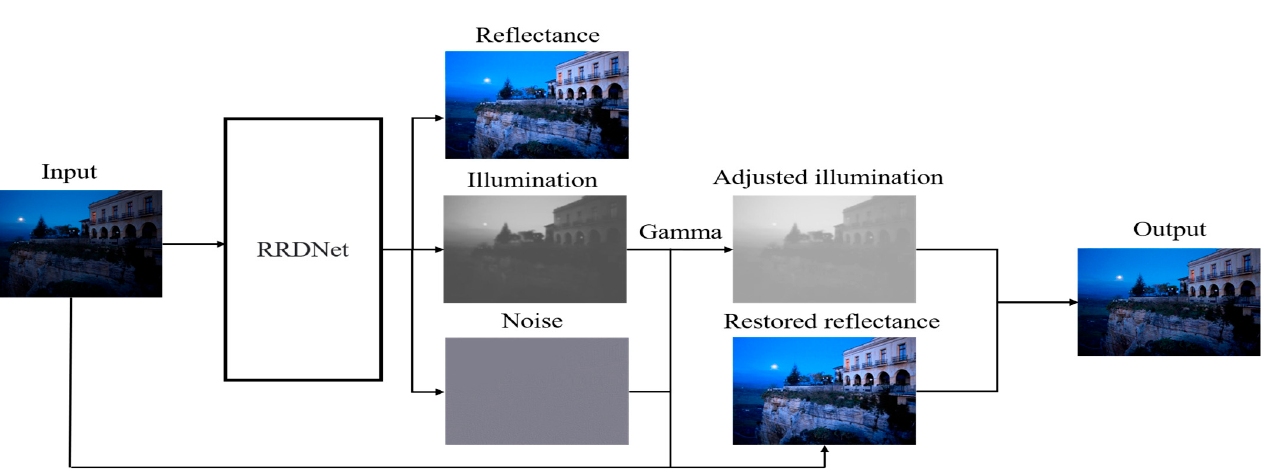
Figure 5. Flowchart of the RRDNet algorithm.